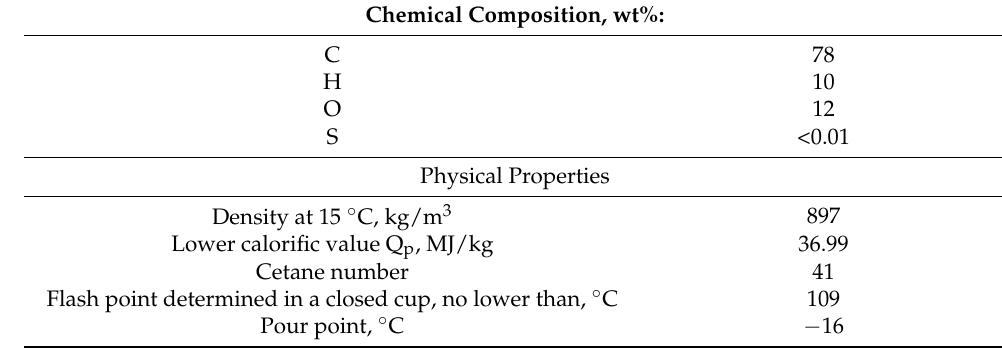
Table 2. Properties of rapeseed